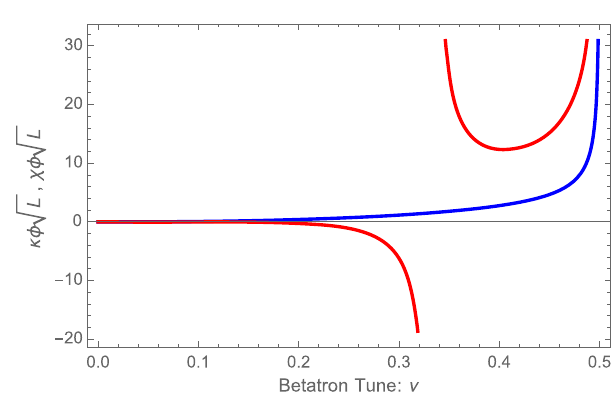
FIG. 5. Resonance driving terms: 3 ν